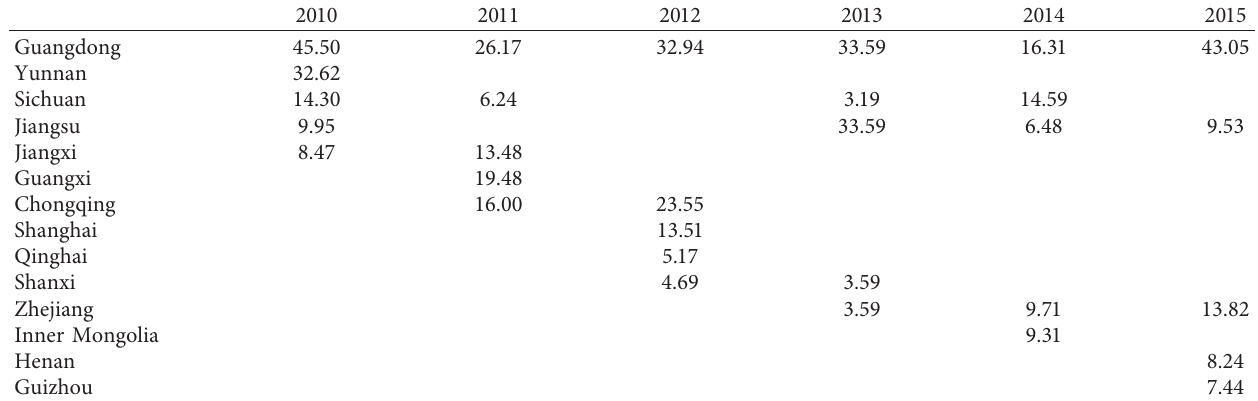
Table 5: The top 5 provinces for population mobility intermediation in